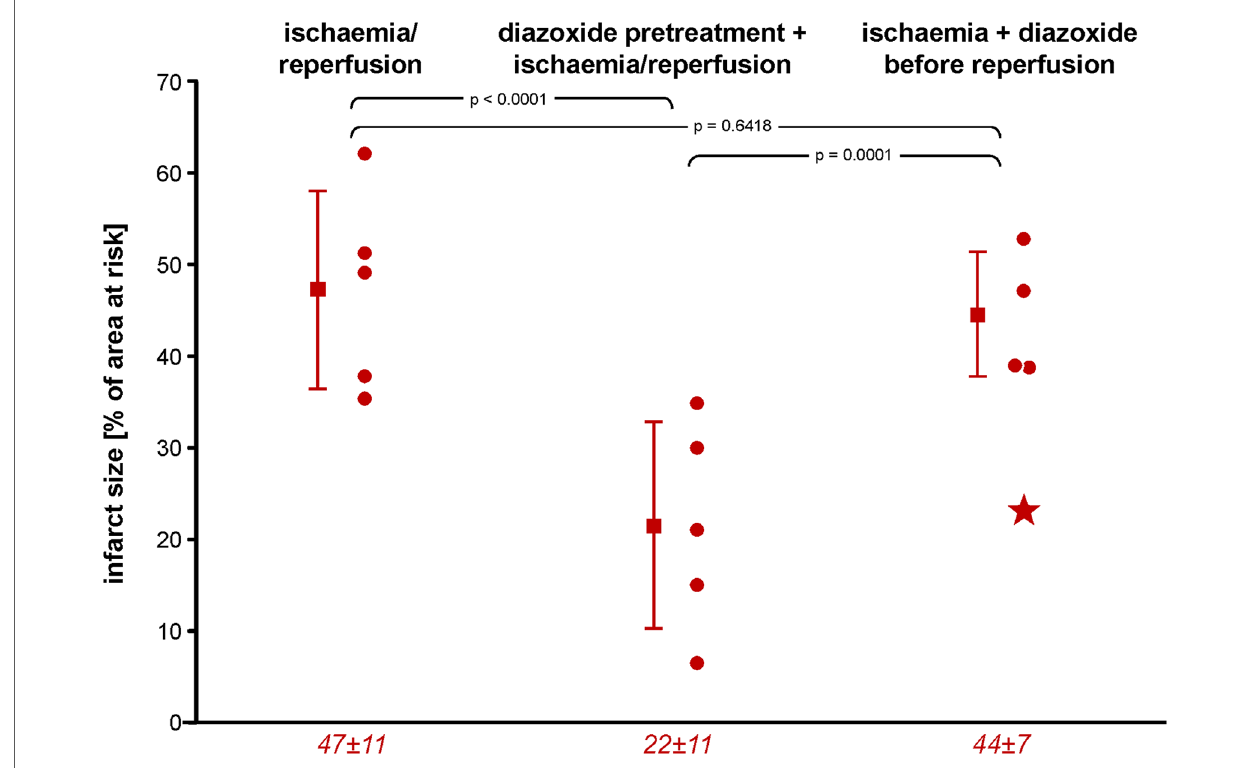
FIGURE 1 Infarct size following ischaemia/reperfusion without and with diazoxide pretreatment or diazoxide before reperfusion, respectively; individual data (circles) and means (squares) with SD; mean±SD are also given as numerical data for ischaemia/reperfusion ( n =5), pretreatment with diazoxide+ ischaemia/reperfusion ( n =5), and diazoxide before reperfusion ( n =4). The asterisk in the scatter plot of data with diazoxide before reperfusion indicates one pig with persistent TTC-positive staining within an area of no-re fl ow, as indicated by the negative thio fl avin-S staining. Data were analysed by one-way analysis of variance and Fisher ’ s LSD post-hoc test s. LSD, least square difference; TTC, triphenyl tetrazolium